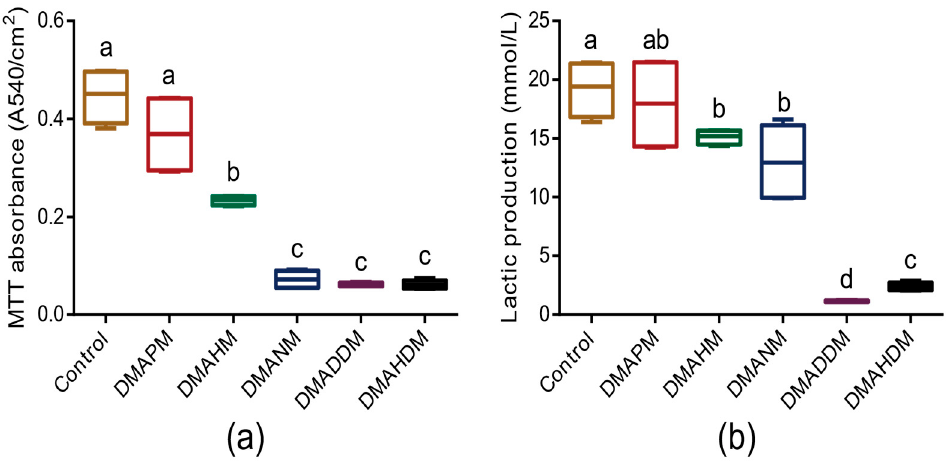
Figure 4. Metabolic activity and lactic acid-producing ability of three-species biofilms on adhesive disks. ( a ) MTT assay for the metabolic activity of three-species biofilms on the adhesive disks ( n = 6); ( b ) the lactic acid produced by the biofilms ( n = 6). Bars with the same letter indicate a value having no significant distance, and those with different letters indicate a significant difference ( p < 0.05).